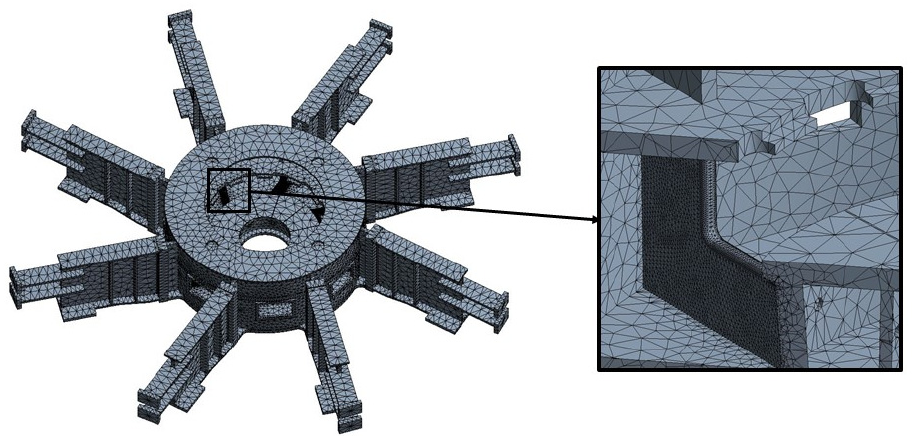
Figure 8. The calculation model of the support bracket.